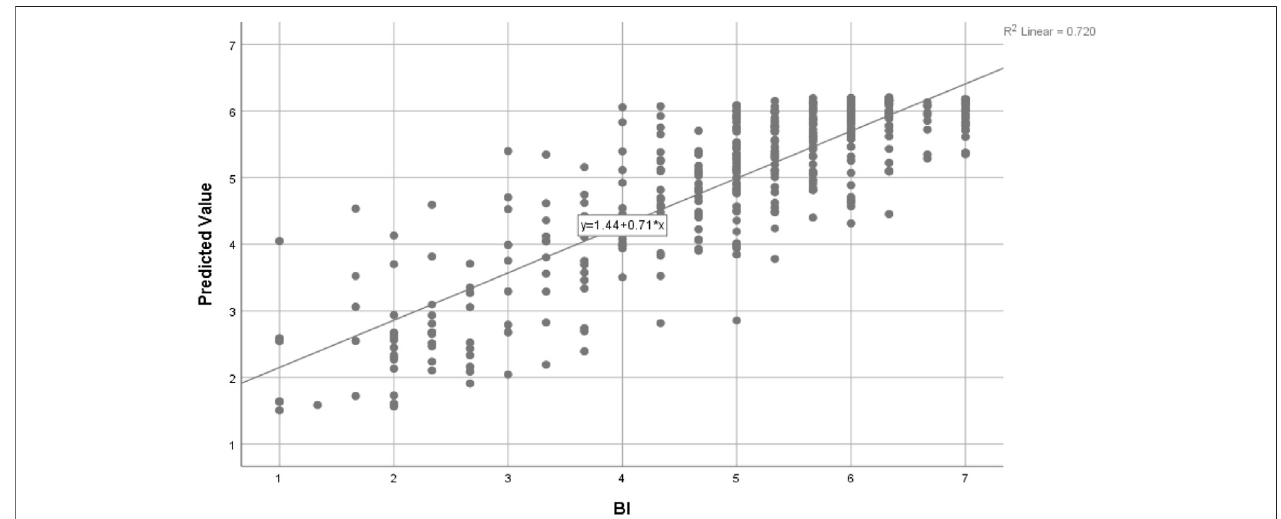
FIGURE 7 | Regression standard residuals for ANN model.